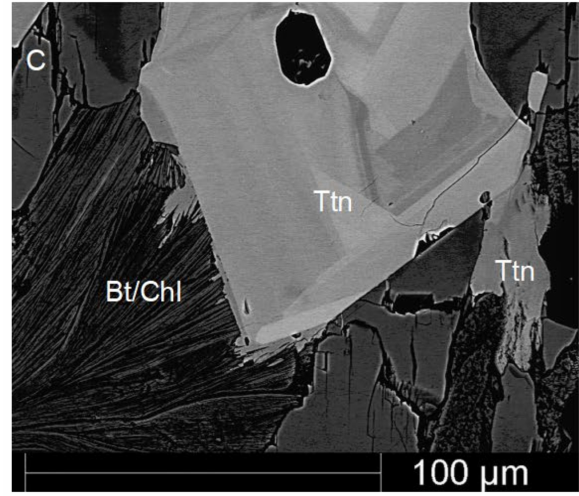
Figure 18. Backscattered electron (BSE) images of ( A ) titanite grains from the Oligocene Little Cottonwood stock, Utah, showing typical euhedral shape for plutonic grains and, on the right side of the photo, overgrowths of titanite (Ttn) out into the surrounding chloritized biotite (Bt and Chl). Other mineral inclusions are magnetite (Mag), apatite (Ap), and ilmenite (Ilm). ( B ) Blow-up of the tip of the grain on the right in ( A ). ( C ) Titanite grain from the Jurassic Notch Peak pluton, Utah, with overgrowth extensions out into a neighboring chloritized biotite.